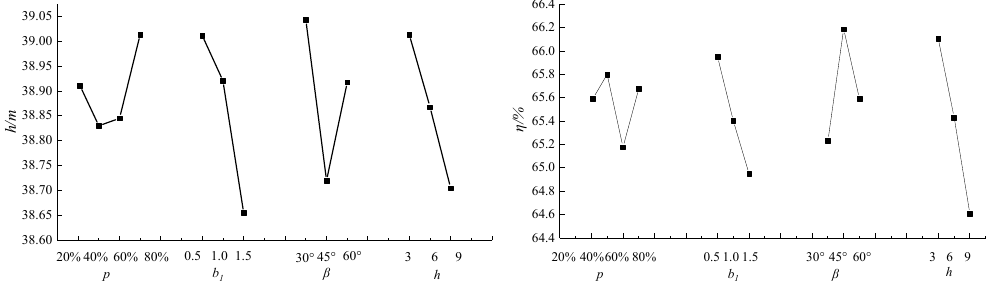
Figure 7. 0.6 Q head ( left ) and efficiency ( right )-factor relationship.